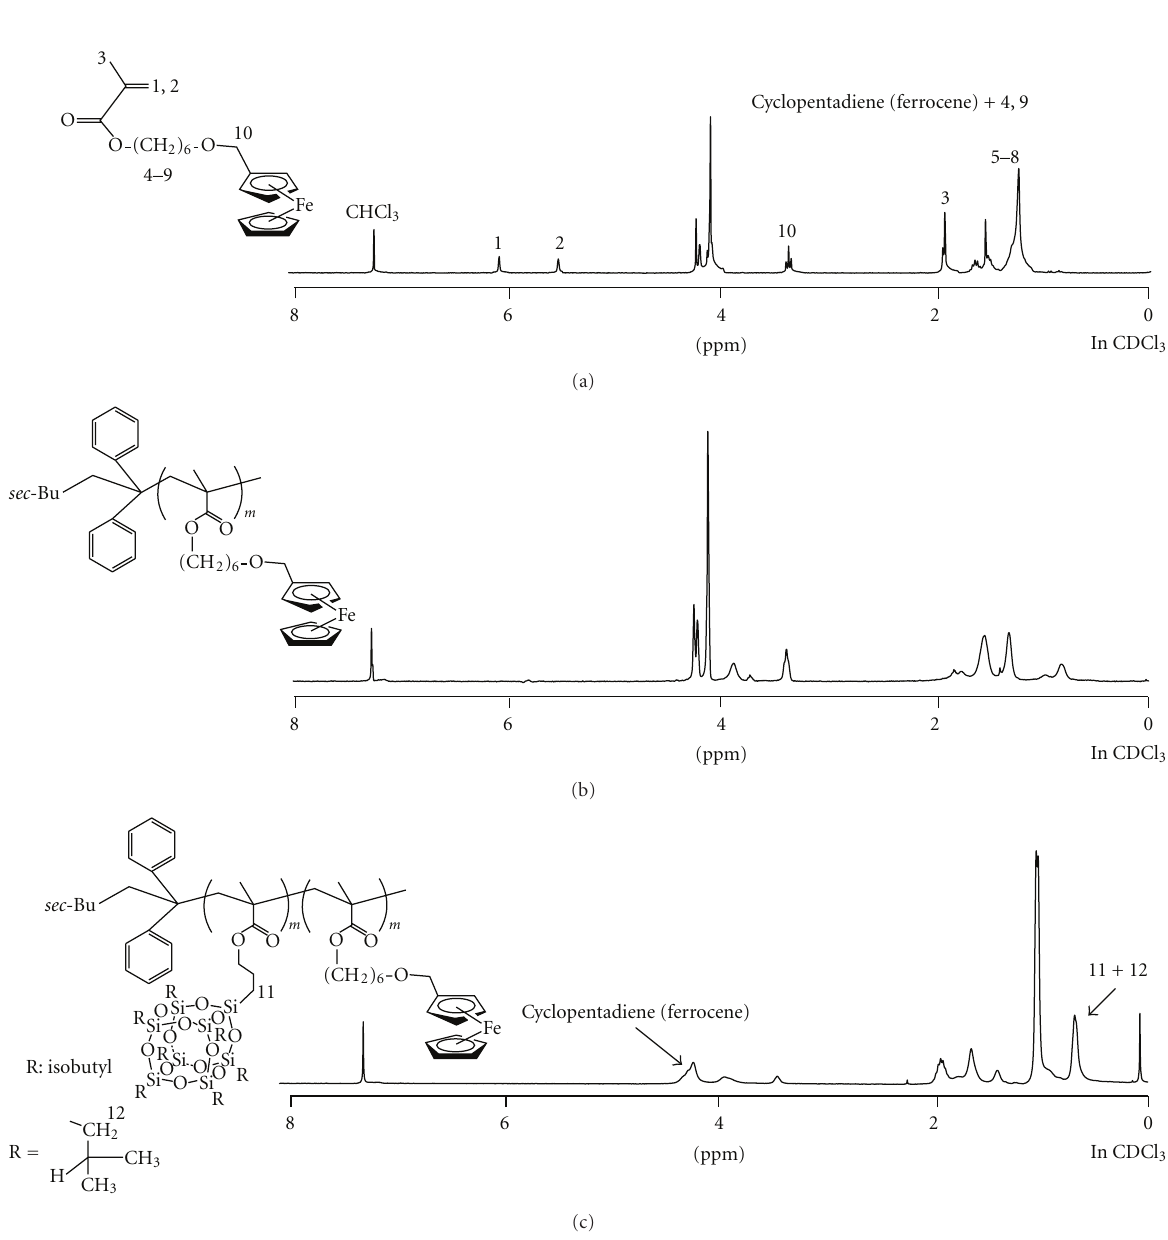
Figure 4: 1 H NMR spectra of (a) MAHFC, (b) PMAHFC, and (c) PMAPOSS- b